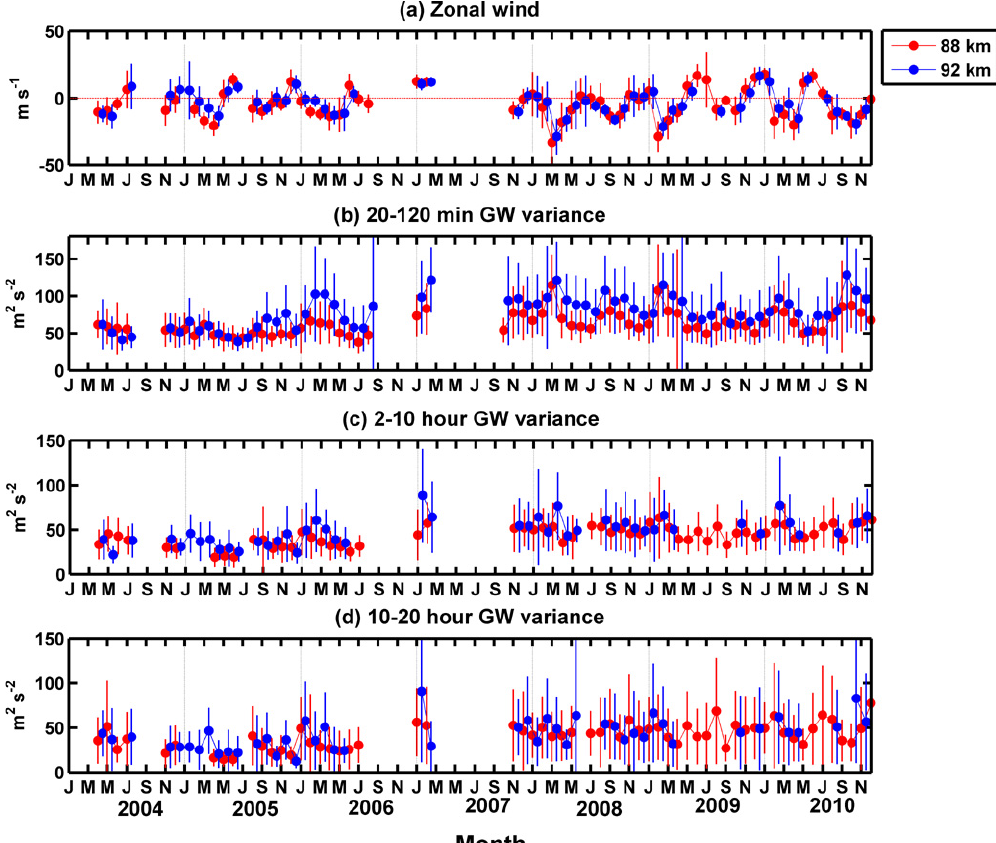
Fig. 2. Variability of the monthly mean (a) zonal wind, (b) 20–120min gravity wave variance, (c) 2–10h gravity wave variance, and (d) 10– 20h gravity wave variance between 2004 and 2010. The GW variance is a mean of zonal and meridional variances (( u vertical lines represent the standard deviations of monthly mean values. The values at 92km are shifted forward by 0.5 of a month.